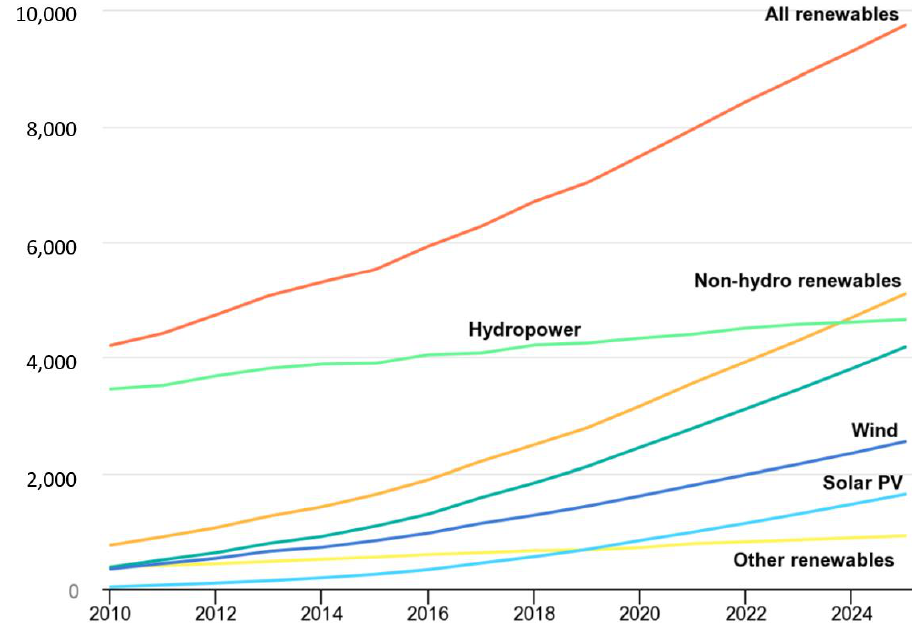
Figure 1. Total renewable energy usage for electricity generation (2010–2025) (Reprinted with permission from Ref. [3]. 2020, IEA)